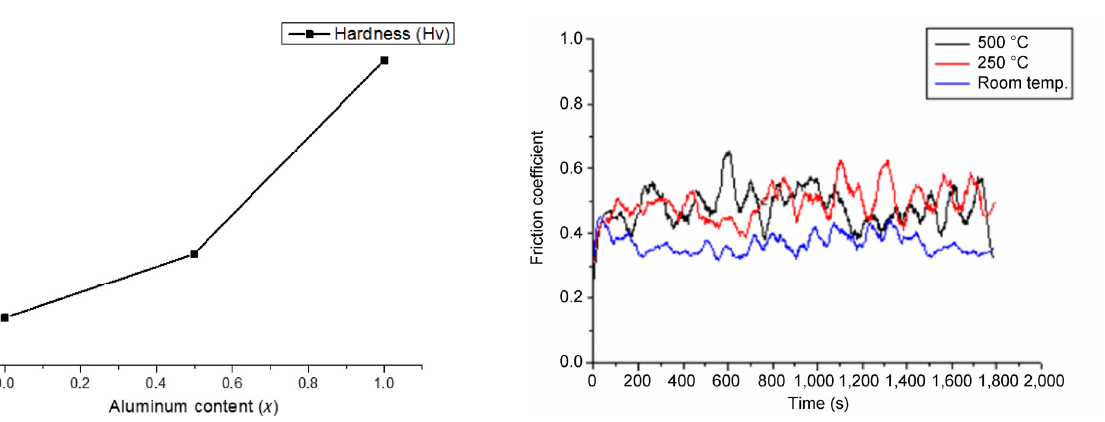
Fig. 5 Vickers hardness of CoCrFeNiTi 0.5 Al x alloys with different aluminum content.